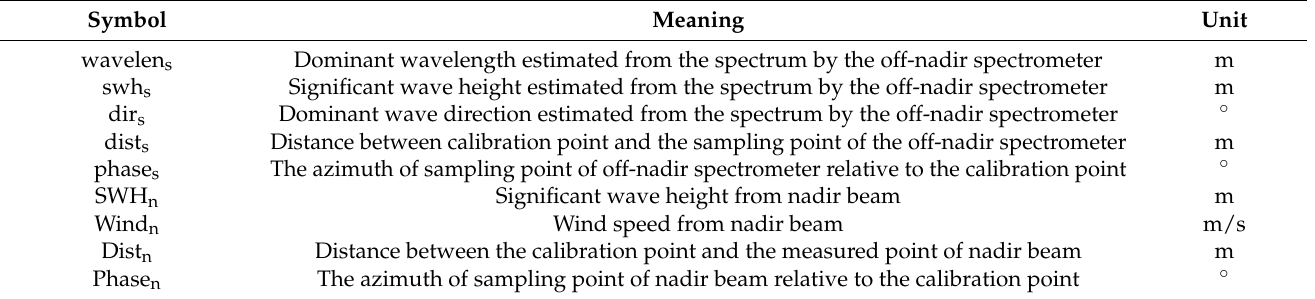
Table 1. List of input parameters for the self-calibration of the dominant